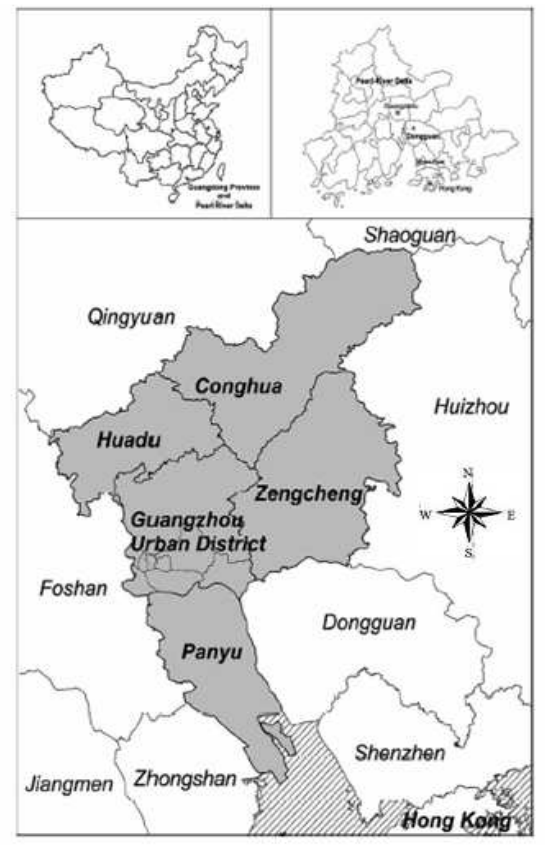
Figure1. Location of study area: Guangzhou Municipality and its main administrative